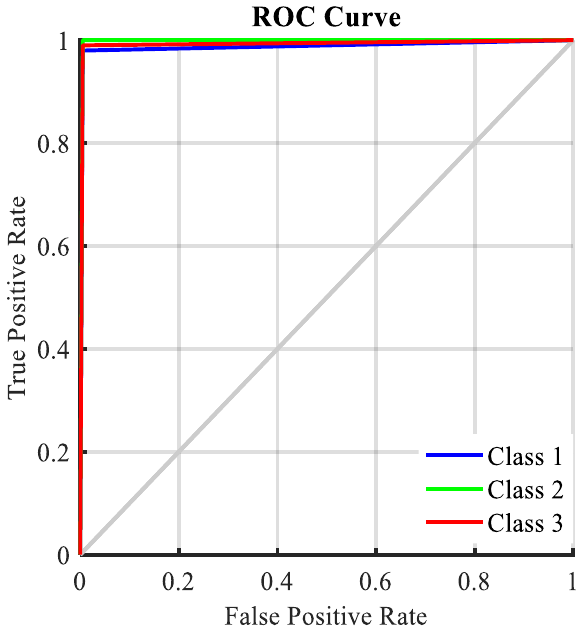
Figure 10. ROC curve for each class.